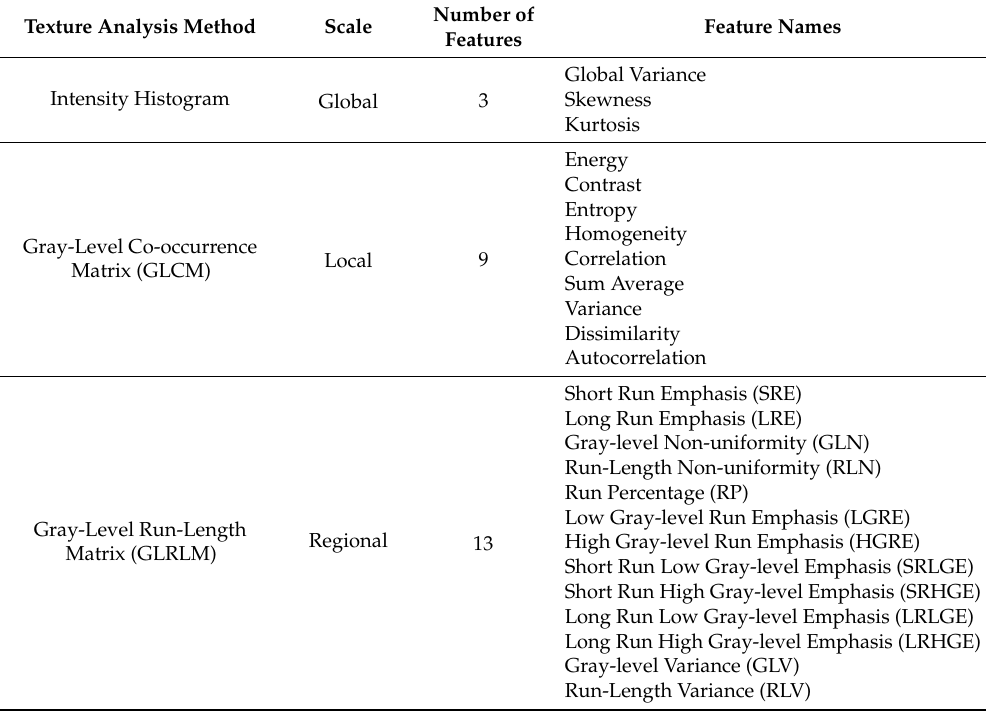
Table 1. List of parameters obtained per region of interest